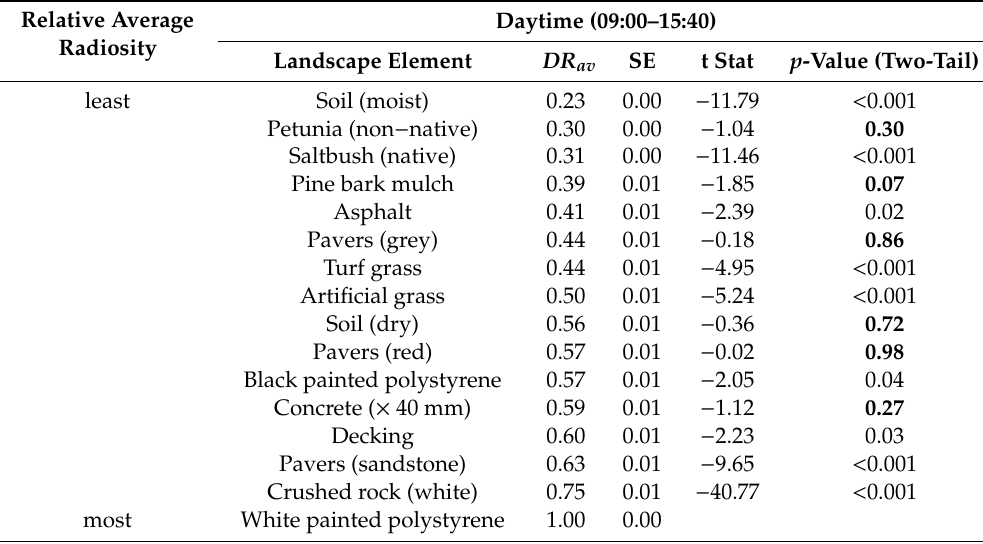
Table 7. Daytime relative average radiosity ( DR av ) of larger, ground-coupled LEs from summer 2019, normalised with WPP. Results of the two sample t-test (assuming equal variances, α = 0.05) are a comparison of each LE with the LE in the row beneath it in the table. The bold p -values indicate the means of these LEs are not statistically di ff